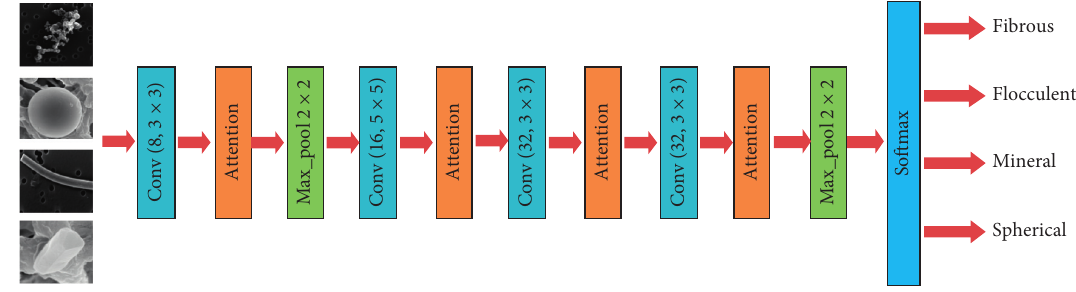
Figure 5: The structure of Attention-CNN